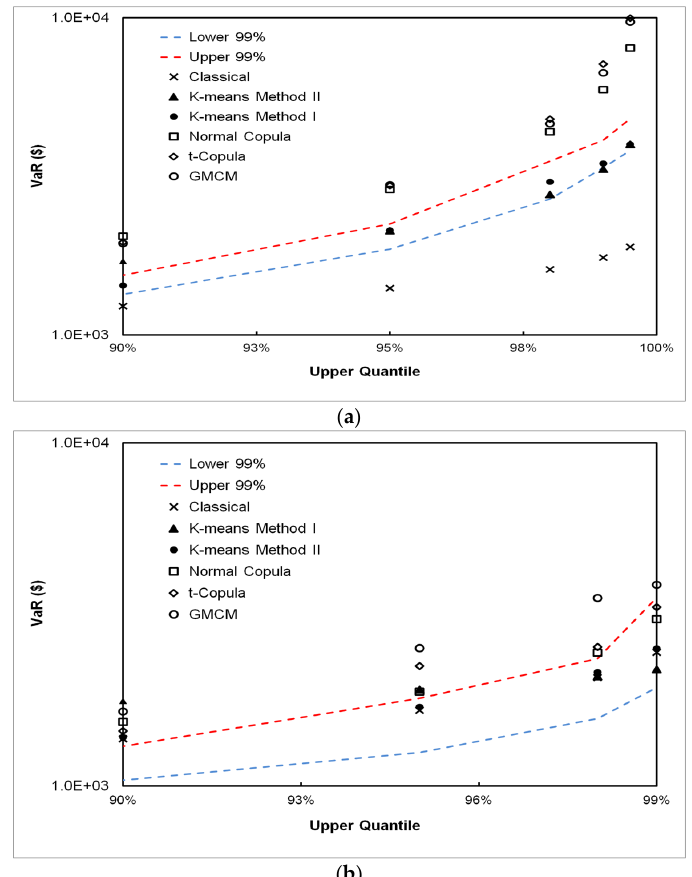
Figure 10. VaR estimates by the classical, DPFS, and CPFS methods for the S & P 500 ( a ) and DJIA data ( b ). DPFS Methods (I) and (II) works the best compared to the historical bootstrap VaR